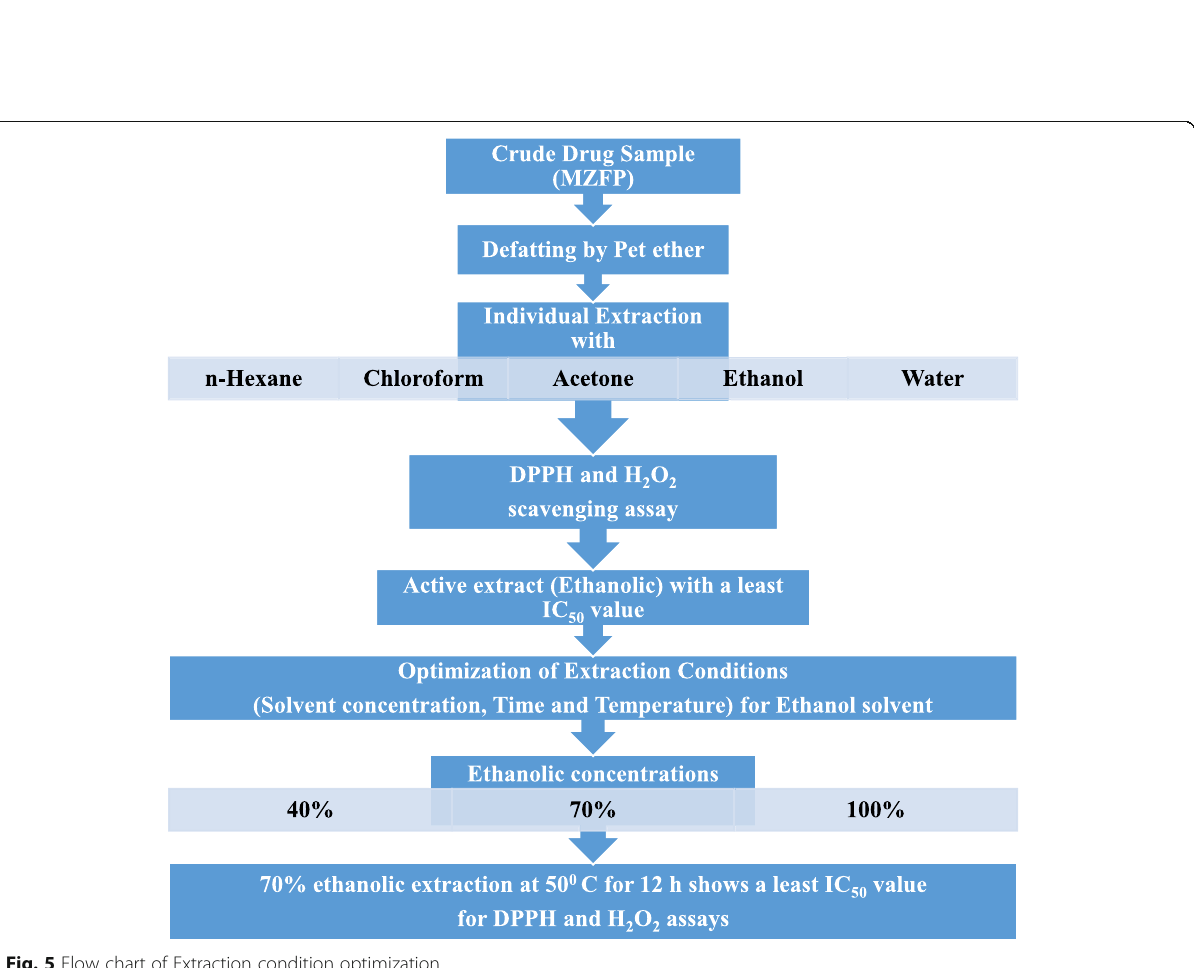
Fig. 5 Flow chart of Extraction condition